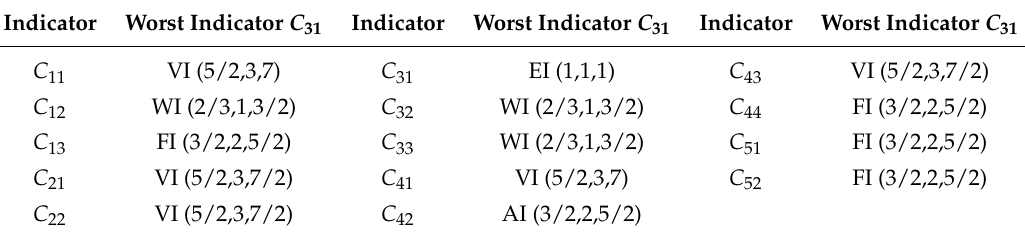
Table 4. Fuzzy ratings of all indicators compared with the worst